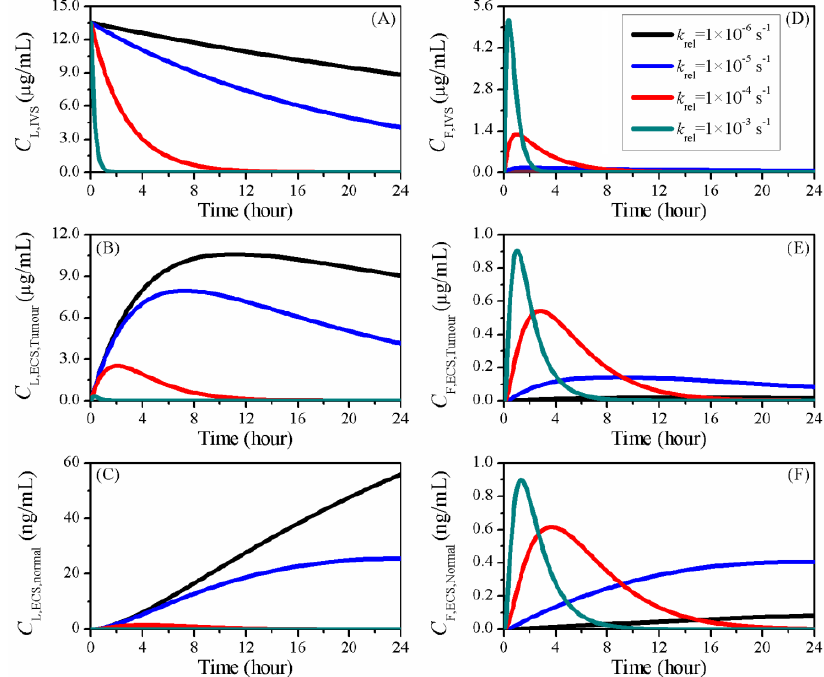
Figure 8. The time courses of doxorubicin concentration in treatments using liposomes with different release rates. Liposome-encapsulated doxorubicin in ( A ) IVS, ( B ) tumour and ( C ) normal tissue ECS; free doxorubicin in ( D ) IVS, ( E ) tumour and ( F ) normal tissue ECS.